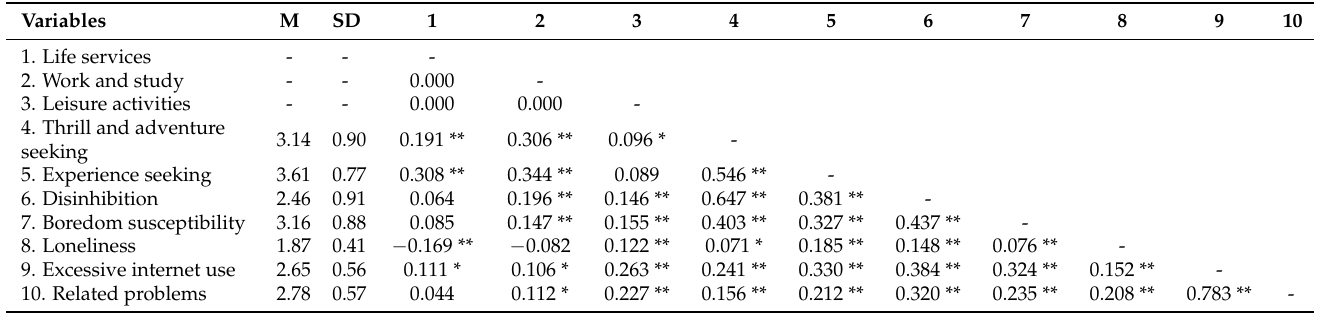
Table 3. Mean, standard deviation, and correlation among variables.